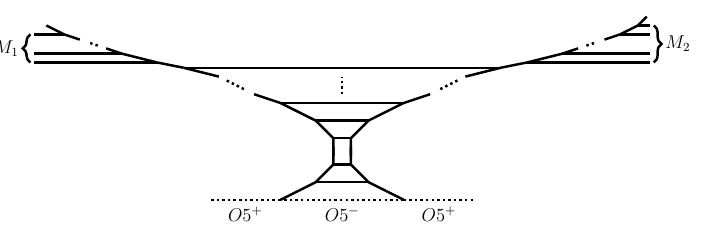
Figure 4 . A 5-brane web for the SO(2 N + 4) gauge theory with M 1 + M 2 hypermultiplets in the vector representation.